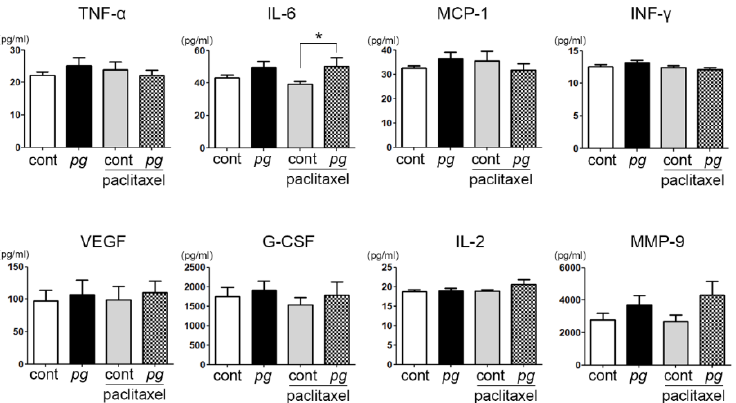
Figure 2. Comparisons of the serum cytokines in tumor xenografts from mice that were administered P. gingivalis and / or paclitaxel. Data are presented as the mean ± standard deviation. Significance was assessed using ANOVA. * P < 0.05.